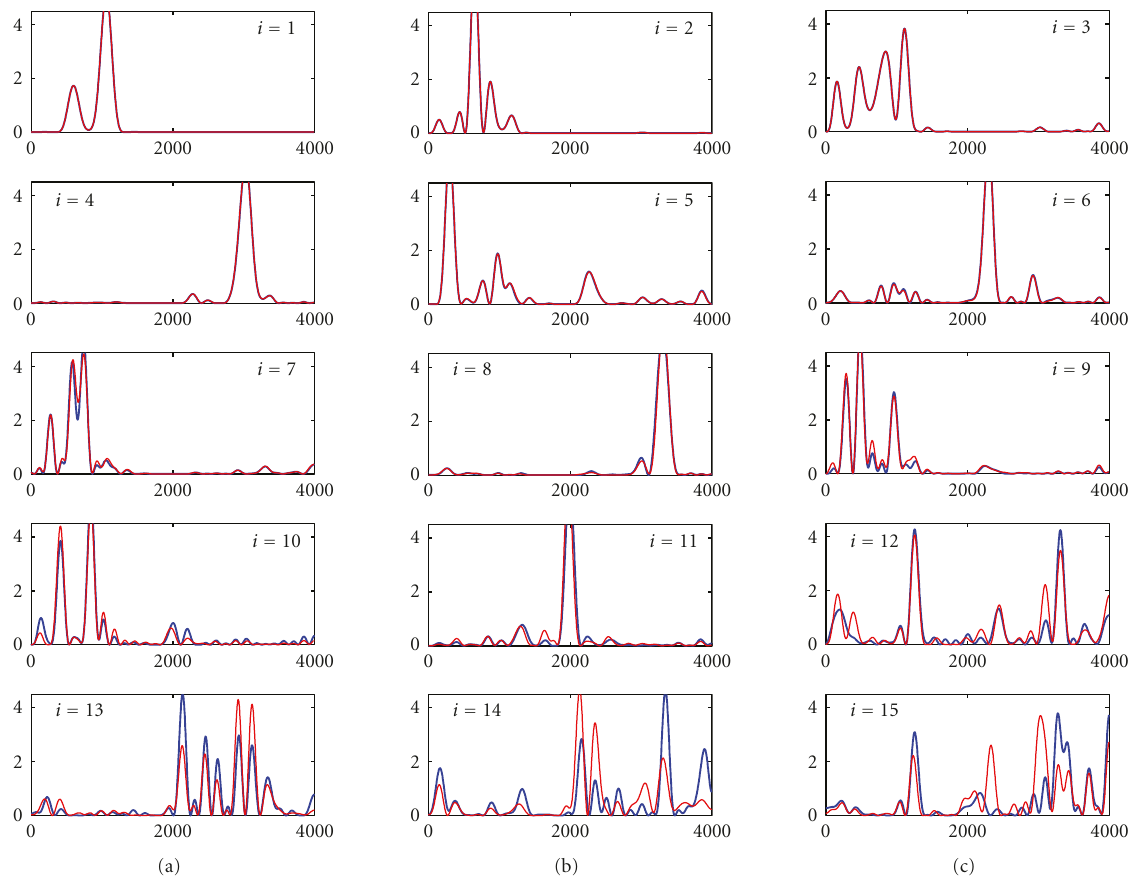
Figure 14: Frequency responses (Magnitude (dB) versus Frequency (Hz)) for the GSVD/ULLV canonical filters, computed via the matrices C C gsvd and ullv . Thick blue lines are GSVD canonical filters; thin red lines are ULLV canonical filters. Most of the canonical filters are almost